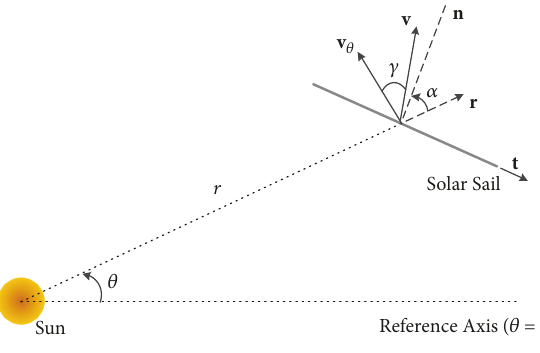
Figure 2: Coplanar polar coordinate system centered on the